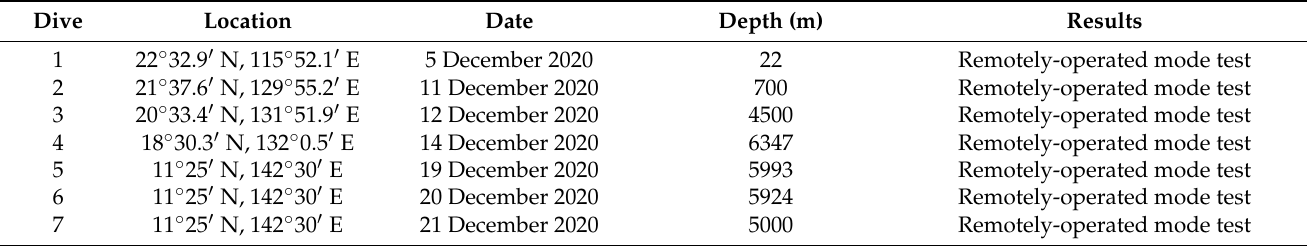
Figure 27. ( a ) Launching ARV using LARS system; ( b ) ARV returns to the water surface. Table 11. Overview of each dive.